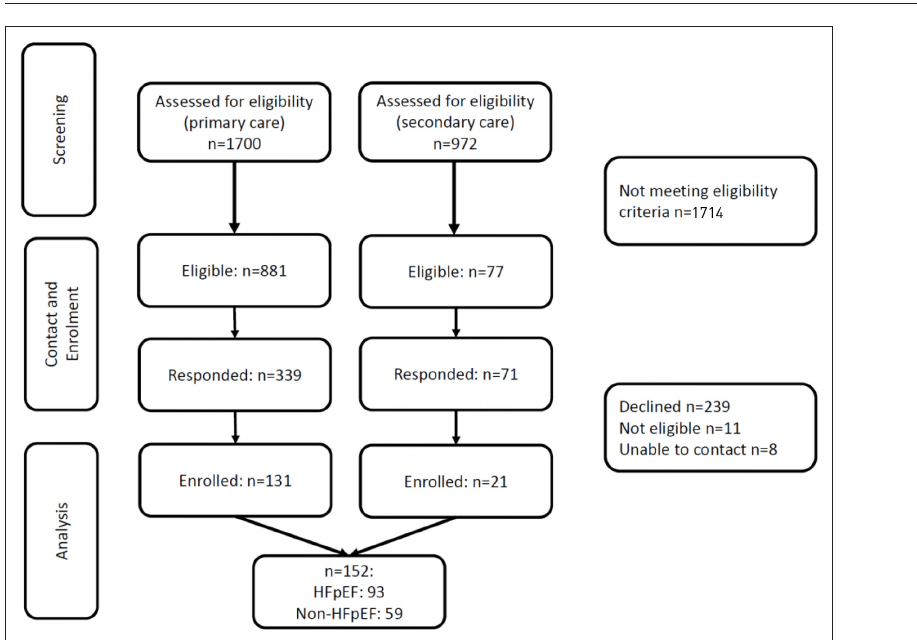
Figure 1 Patient flow chart. HFpFF = heart failure with preserved ejection